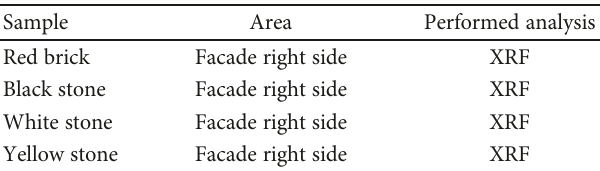
Figure 3: Photo of the investigated pottery fragments from the archaeological site of Scifì: (a) SC1, (b) SC2, (c) SC3, and (d) SC4. Table 2: Information relative to the investigated samples from the Abbey of SS. Pietro e Paolo d ’